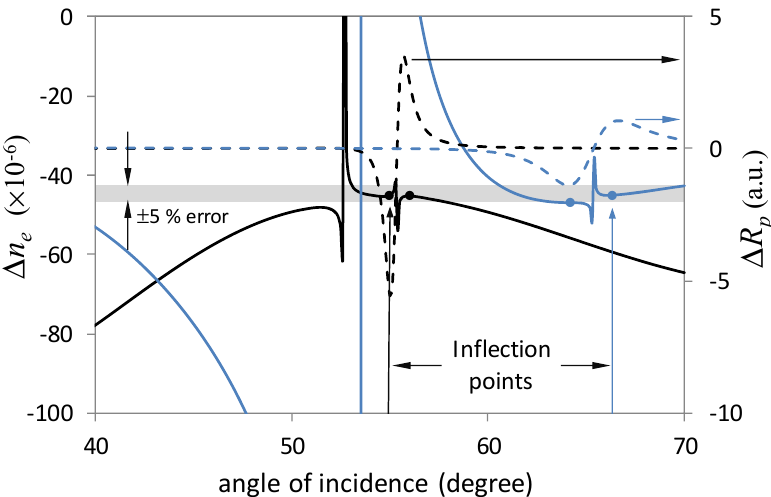
Figure 7. Simulated Δ n a 30 nm thick gold (black) and a Delta Technology ITO (blue) under assumption of no errors in anisotropic indices of n directly corresponding to the error bound of an EO coefficient r